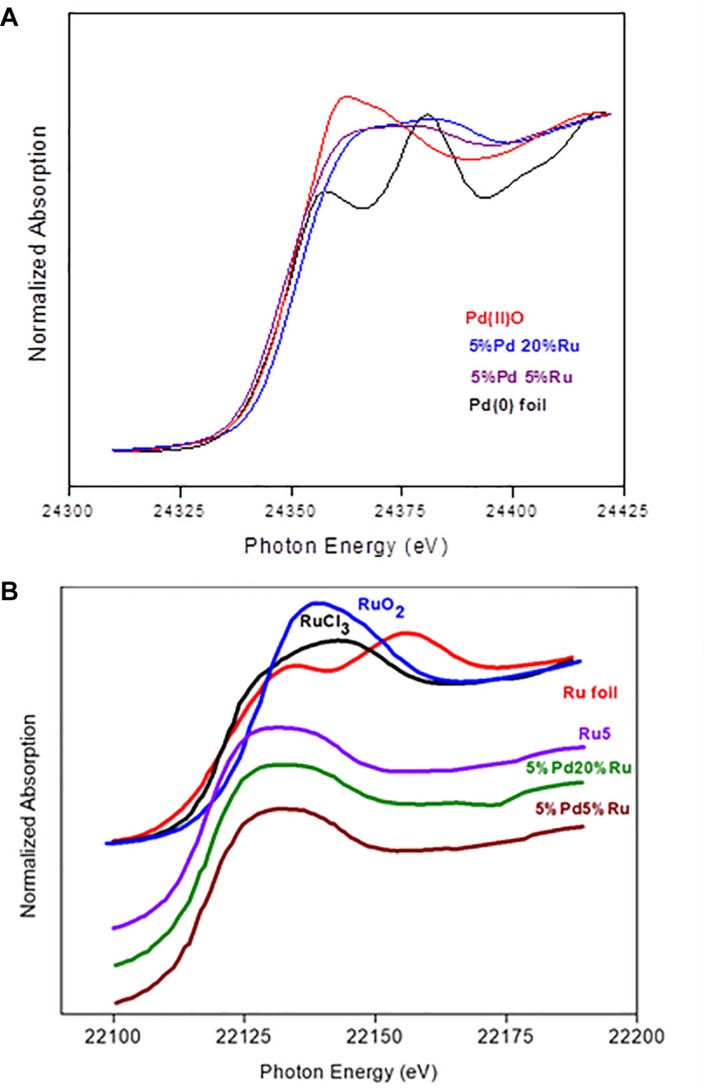
(A) XANES region of EXAFS spectra of the Pd K-edge in reference compounds (Pd foil and PdO) and for Pd-Ru biogenic NPs samples. (B) XANES spectra of ruthenium foil, RuO2, RuCl3, 5% Ru, and for Pd-Ru biogenic NPs samples.